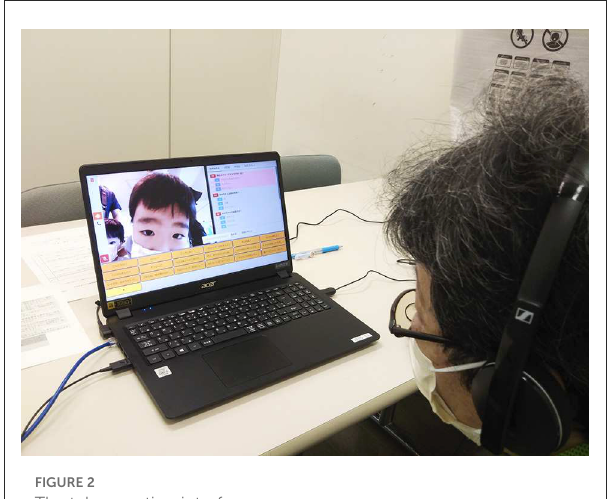
FIGURE2 The teleoperation interface.